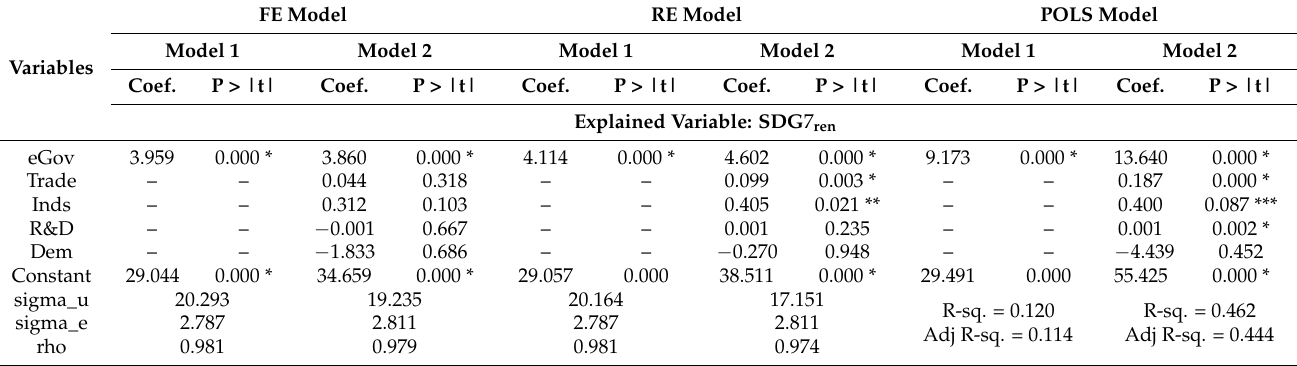
Table 4. The empirical results of e-governance impact on the share of renewable energy in total primary energy supply using the FE, RE, and POLS